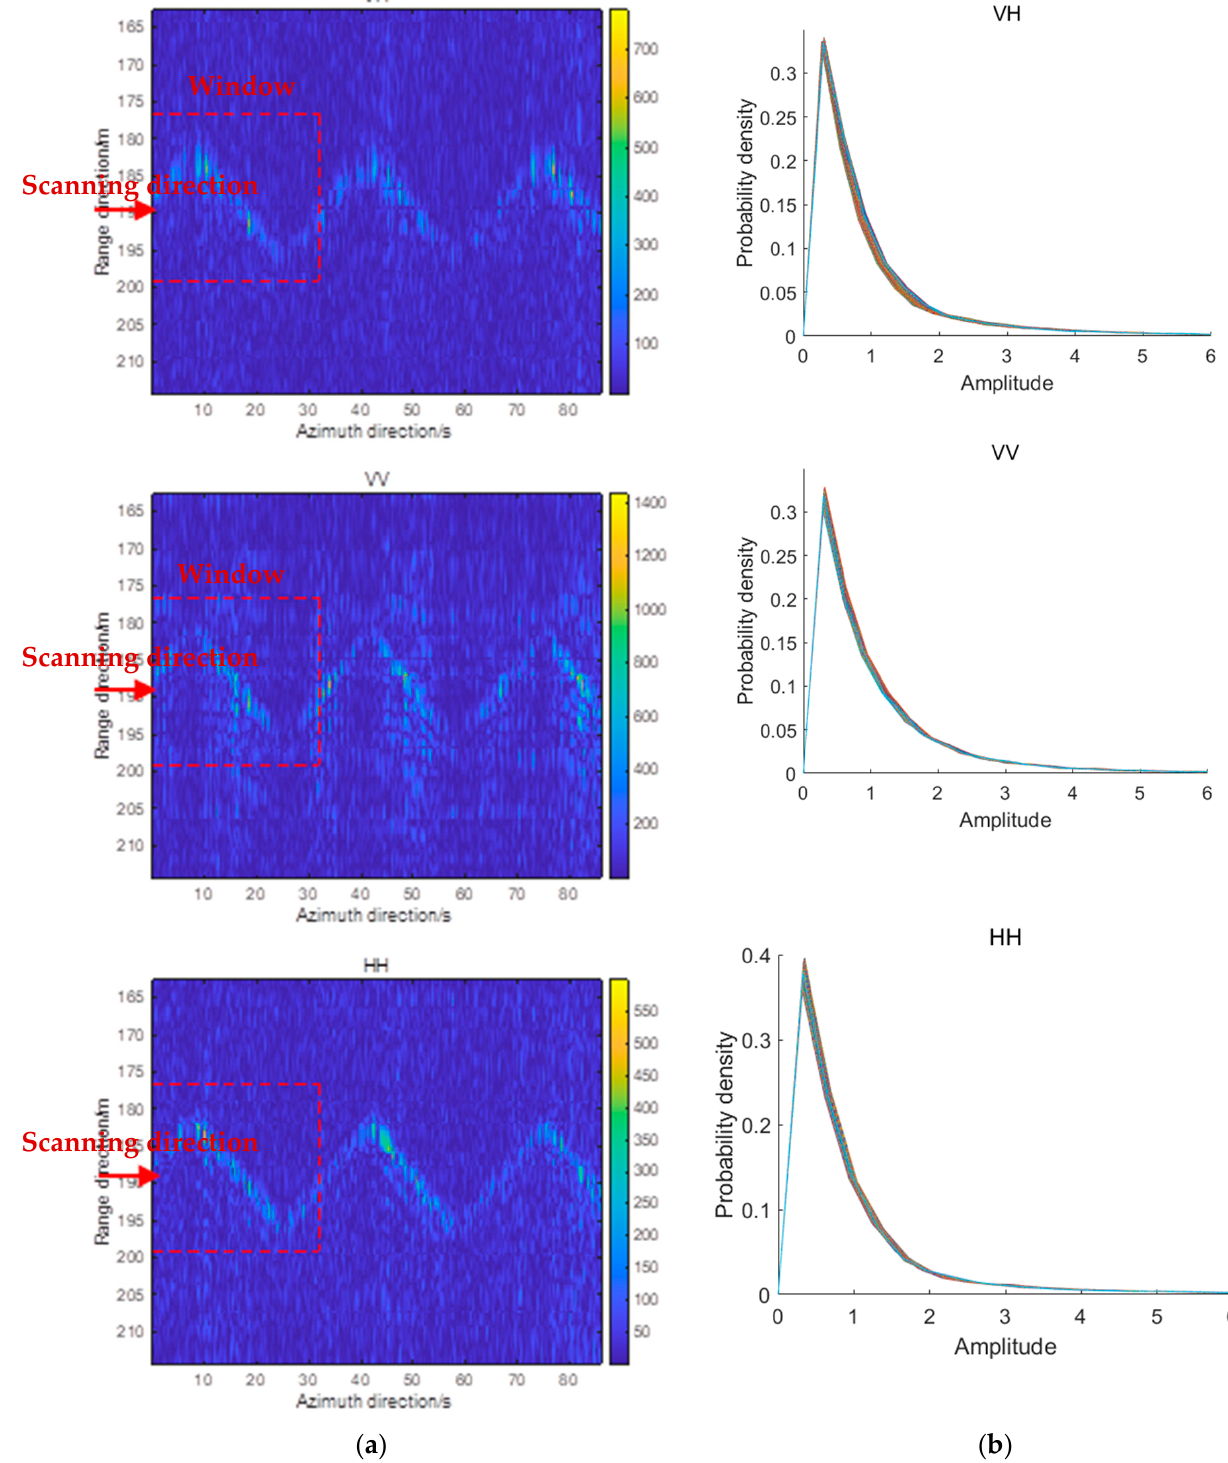
Figure 10. The probability density curves for the pedestrian. ( a ) 2D range compressed profile and its sampling window. ( b ) The curves of probability density function.